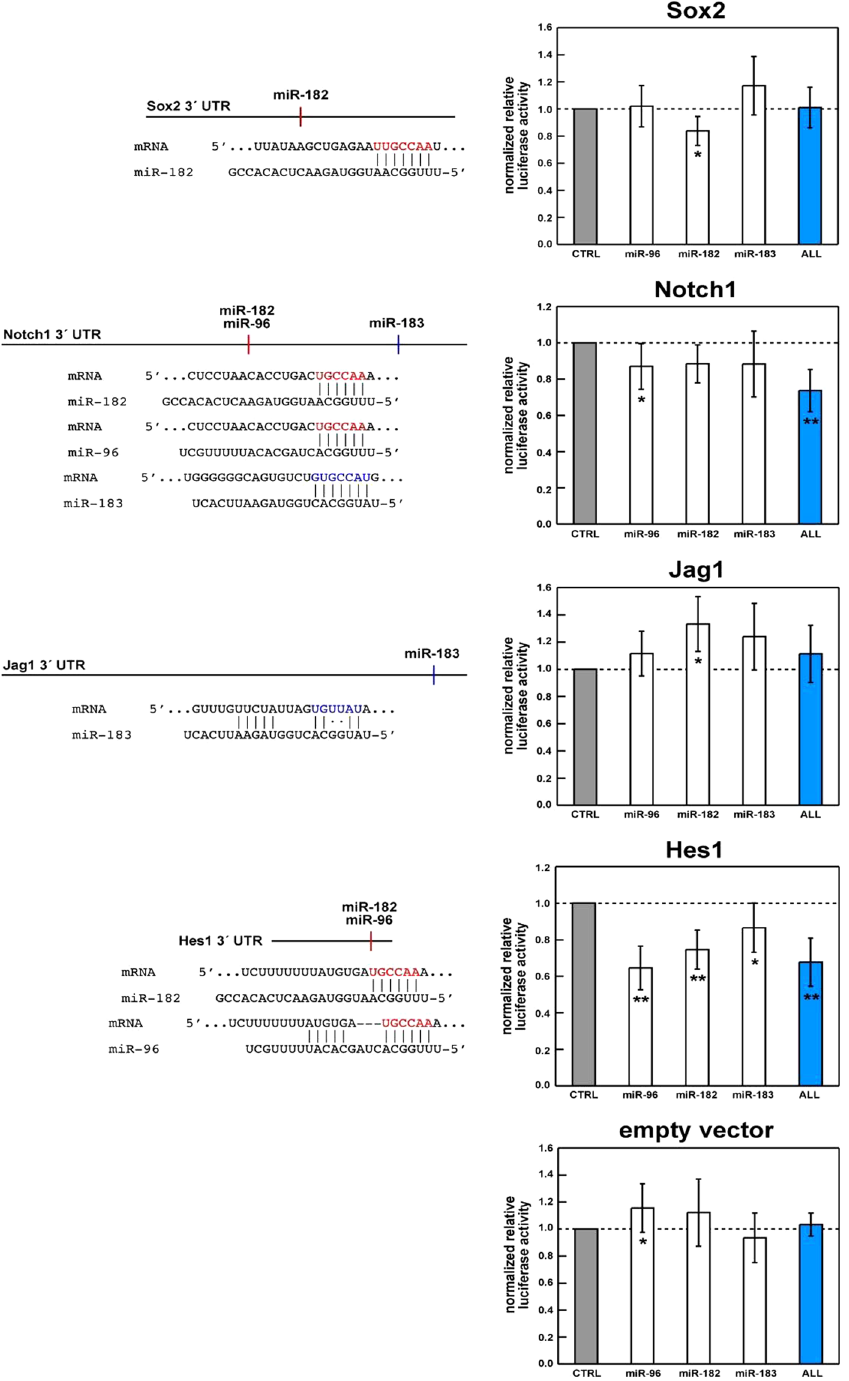
Figure 4. Validation of Sox2 , Notch1 , and Hes1 as miR-183 cluster by dual luciferase assays. Histograms of mean relative luciferase activity in HEK293 cells co-transfected with a dual reporter vector (pmirGLO) containing cloned DNA sequences corresponding to the 3 ′ UTR of the indicated genes plus synthetic miRNA duplexes representing miR-96, miR-182, miR-183, or all three (ALL) normalized to scrambled siRNA control (CTRL). DNA sequences corresponding to the 3 ′ UTRs of Sox2 , Notch1 , Jag1 , and Hes1 were inserted downstream of the pmirGLO Photinus open reading frame. For each assay, the ratio of Photinus and Renilla luciferase activity in cells co-transfected with reporter vector and synthetic miRNA was normalized to that of cells transfected with reporter vector and scrambled siRNA. Each bar represents two replicate readings from each of six transfections performed over three experiments. Error bars indicate the standard error of the normalized mean. The Wilcoxon signed rank test was used to determine statistically significant differences in relative luciferase activity compared to control. Asterisks indicate P < 0.01 ( * ) and P < 0.005 ( **